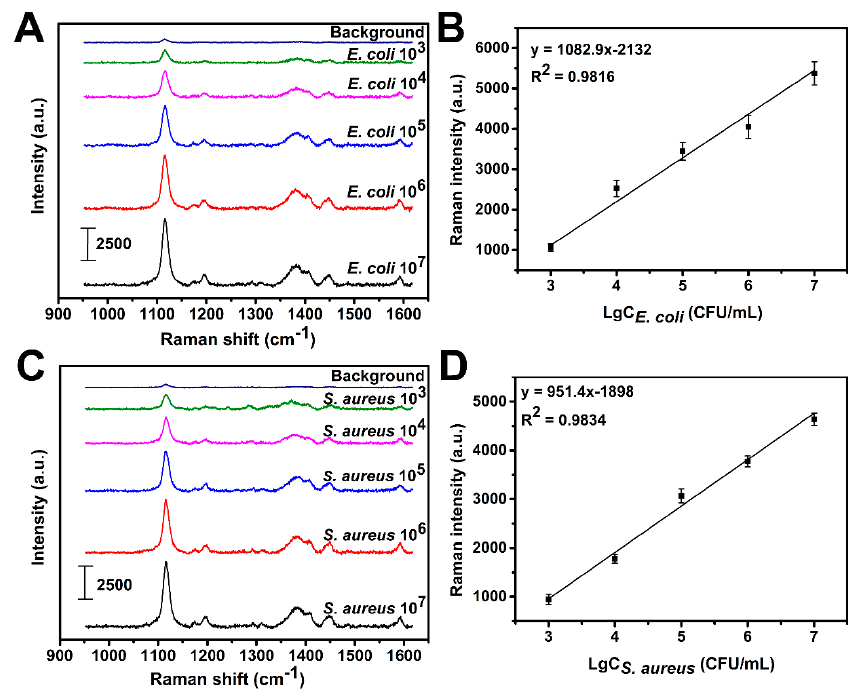
Figure 4. Raman spectra of Au − Azo@Ag − CTAB nanotags after co-incubation with different concen- trations of ( A ) E. coli and ( C ) S. aureus . Calibration curve between the Raman signal intensity with the concentration of ( B ) E. coli and ( D ) S. aureus .